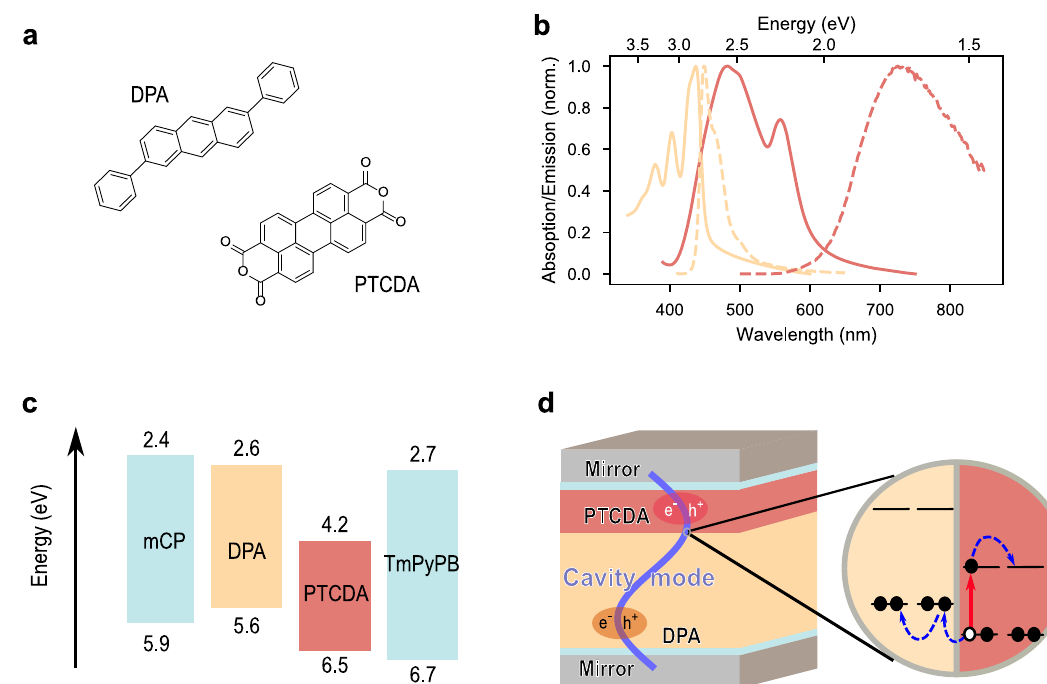
Fig. 1 Molecular system and device architecture. a Molecular structures of 2,6-diphenylanthracene (DPA) and perylene-3,4,9,10-tetracarboxylic dianhydride (PTCDA). b The normalized absorption (solid line) and emission (dash line) spectra of DPA (yellow) and PTCDA (red) fi lms. c Energy-level diagram of each molecule used in the study. To avoid any potential effect from the Ag mirrors, thin spacer layers was used. 10-nm mCP is chosen as the spacer between the bottom Ag mirror and DPA, and 15-nm TmPyPB between PTCDA and the top Ag mirror. The wide energy gap of the chosen materials enables them to act as an inert spacer, and neither energy nor electron transfer occurs between the spacers and active materials when in direct contact. d A typical structure of a Fabry – Pérot cavity in the study. From bottom to top: 30-nm Ag, 10-nm mCP, 163-nm DPA, 40-nm PTCDA, 15-nm TmPyPB, and 50-nm Ag. Schematics of the charge separation in the HJ are also